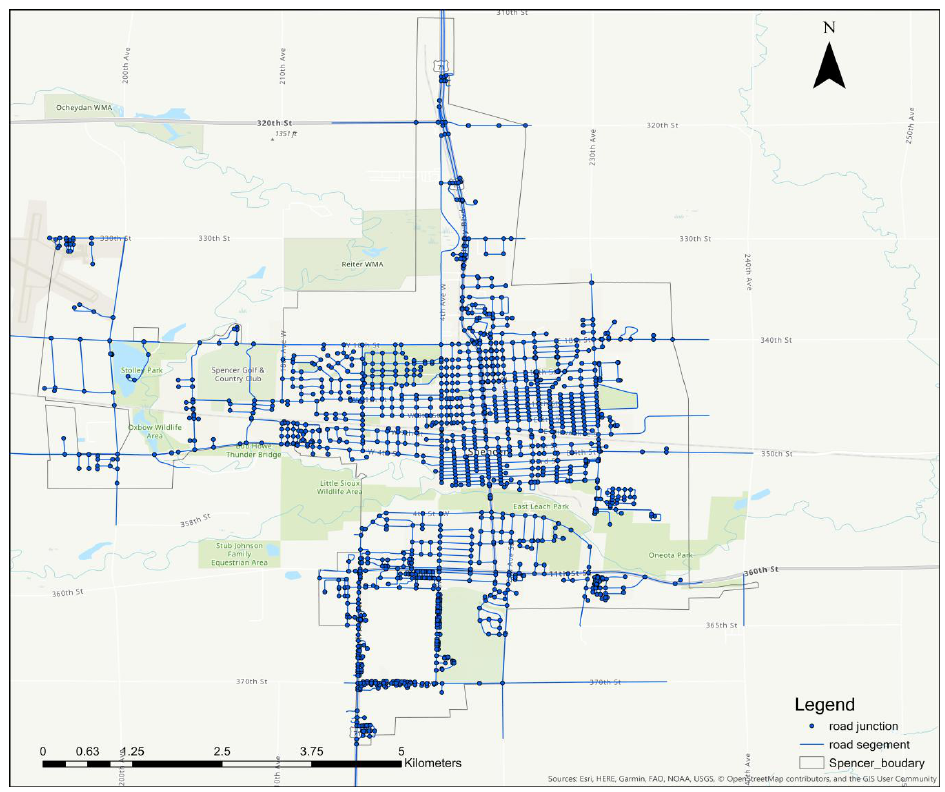
Figure 6. Distribution of the road network in Spencer city.